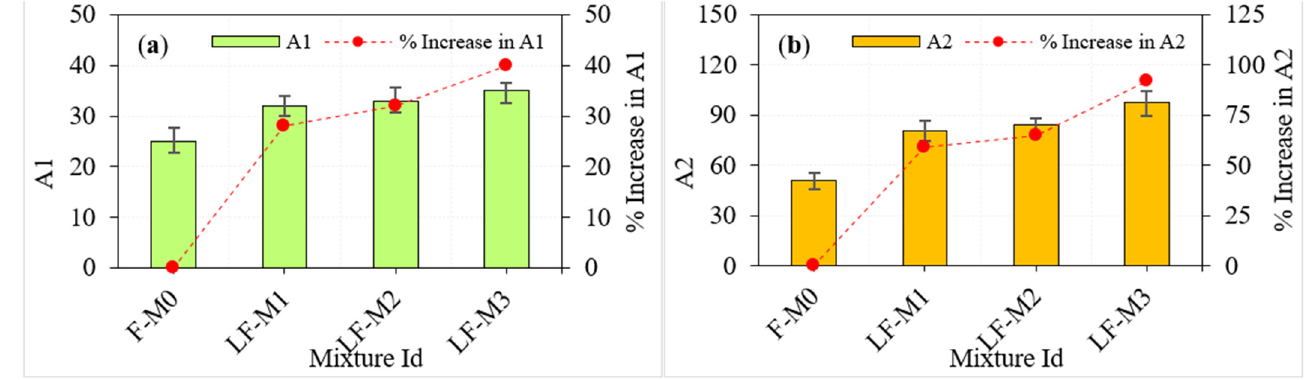
Figure 7. Impact test results of layered fibrous specimens. ( a ) A1 ( b ) A2.